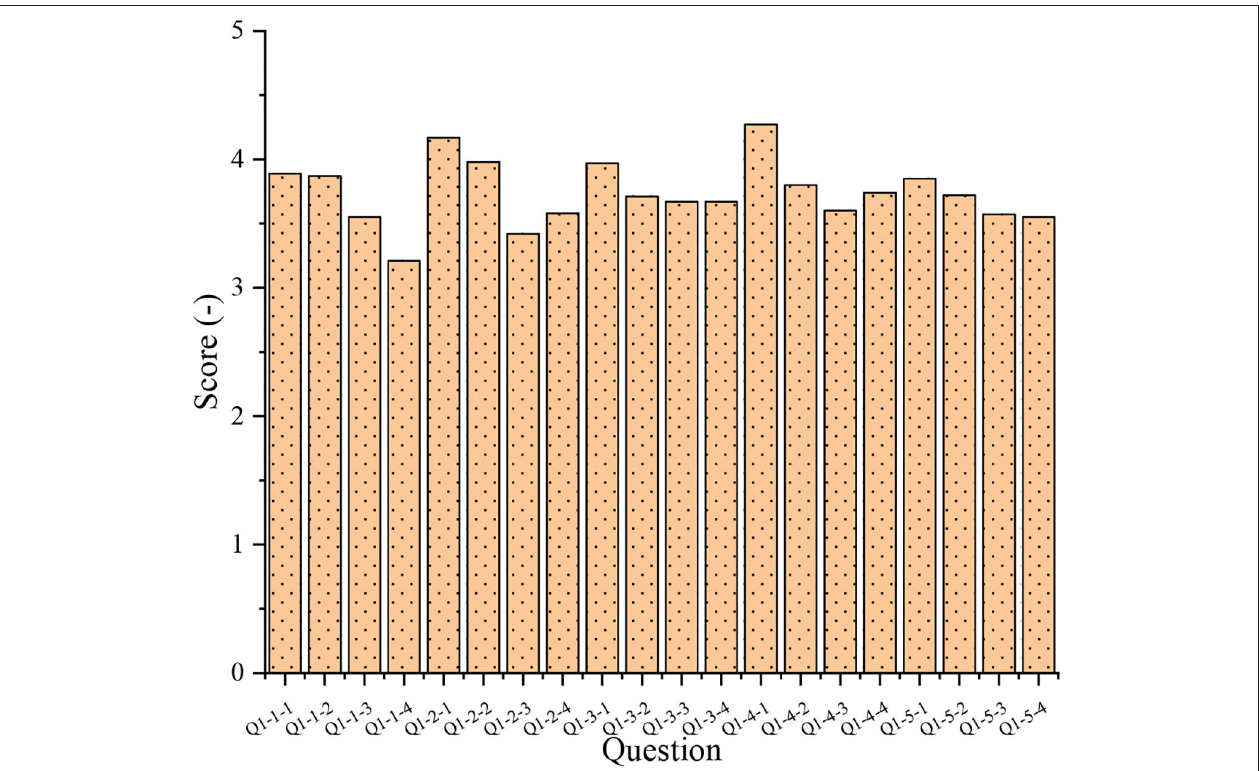
FIGURE 5 | An analysis of the basic situation of college-student entrepreneurs during school.